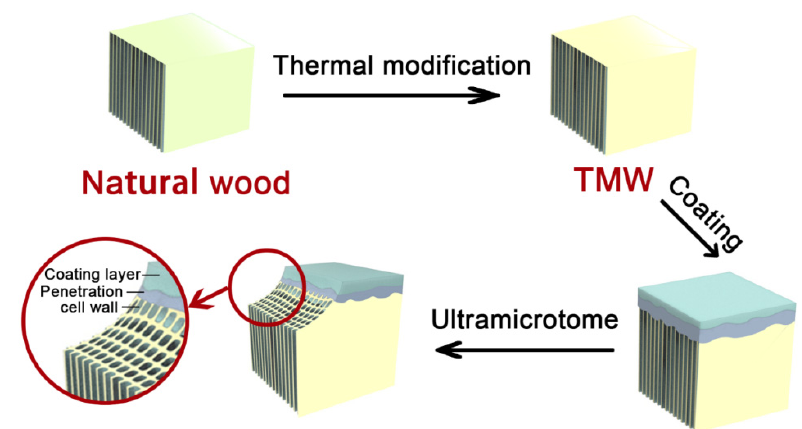
Figure 1. Schematic diagram of the preparation of the sample. Thermally modified woods